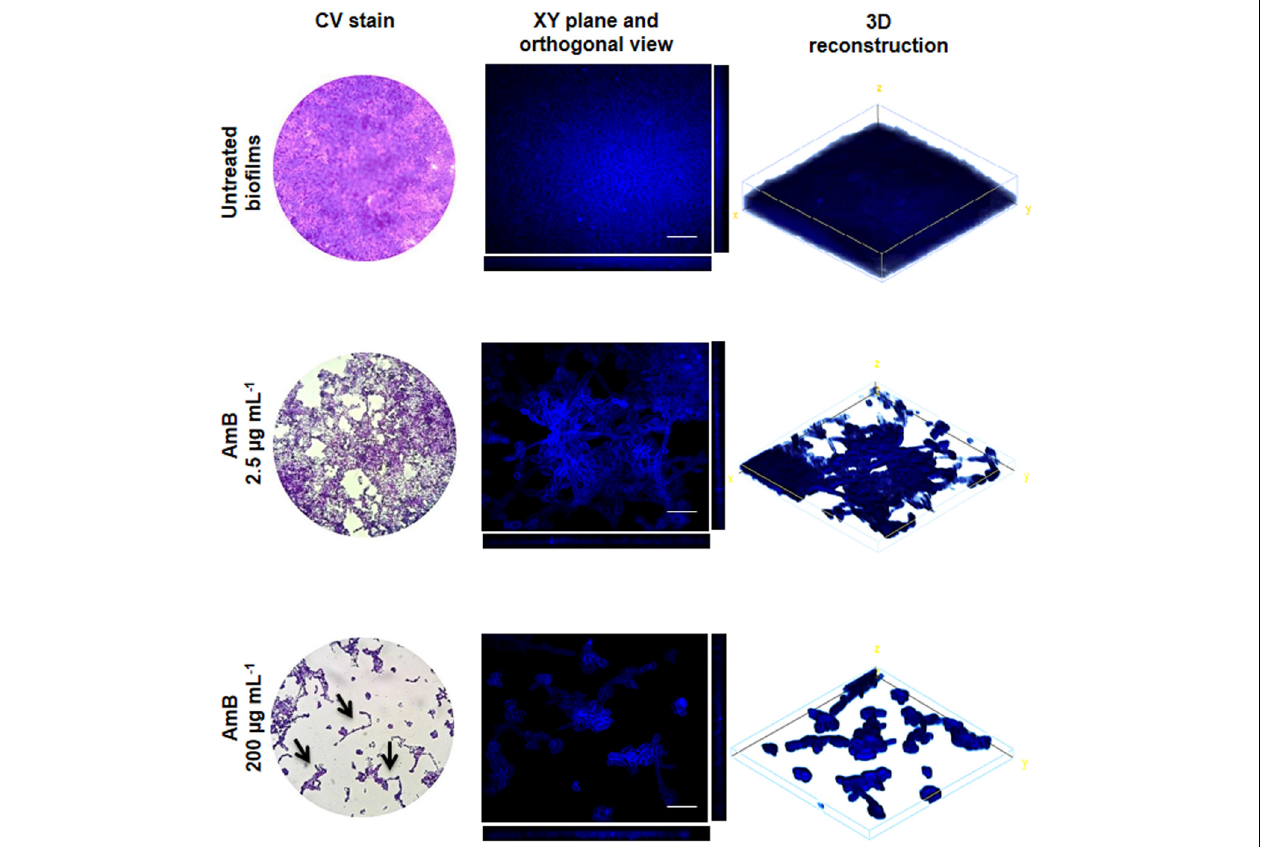
FIGURE 3 | Analysis of Candida tropicalis NCPF 3111 biofilms by light microscope (LM) and confocal laser scanning microscopy (CLSM) images. The images correspond to untreated and treated with Amphotericin B (AmB) 2.5 and 200 µ g mL − 1 biofilms. For LM, samples were stained by crystal violet (CV) and observed at 400 × magnification. CLSM images show XY (top) and XZ (bottom) planes and the 3D image reconstruction of biofilms stained with Calcofluor-White and observed at 600 × magnification. Scale bar : 10 µ m.